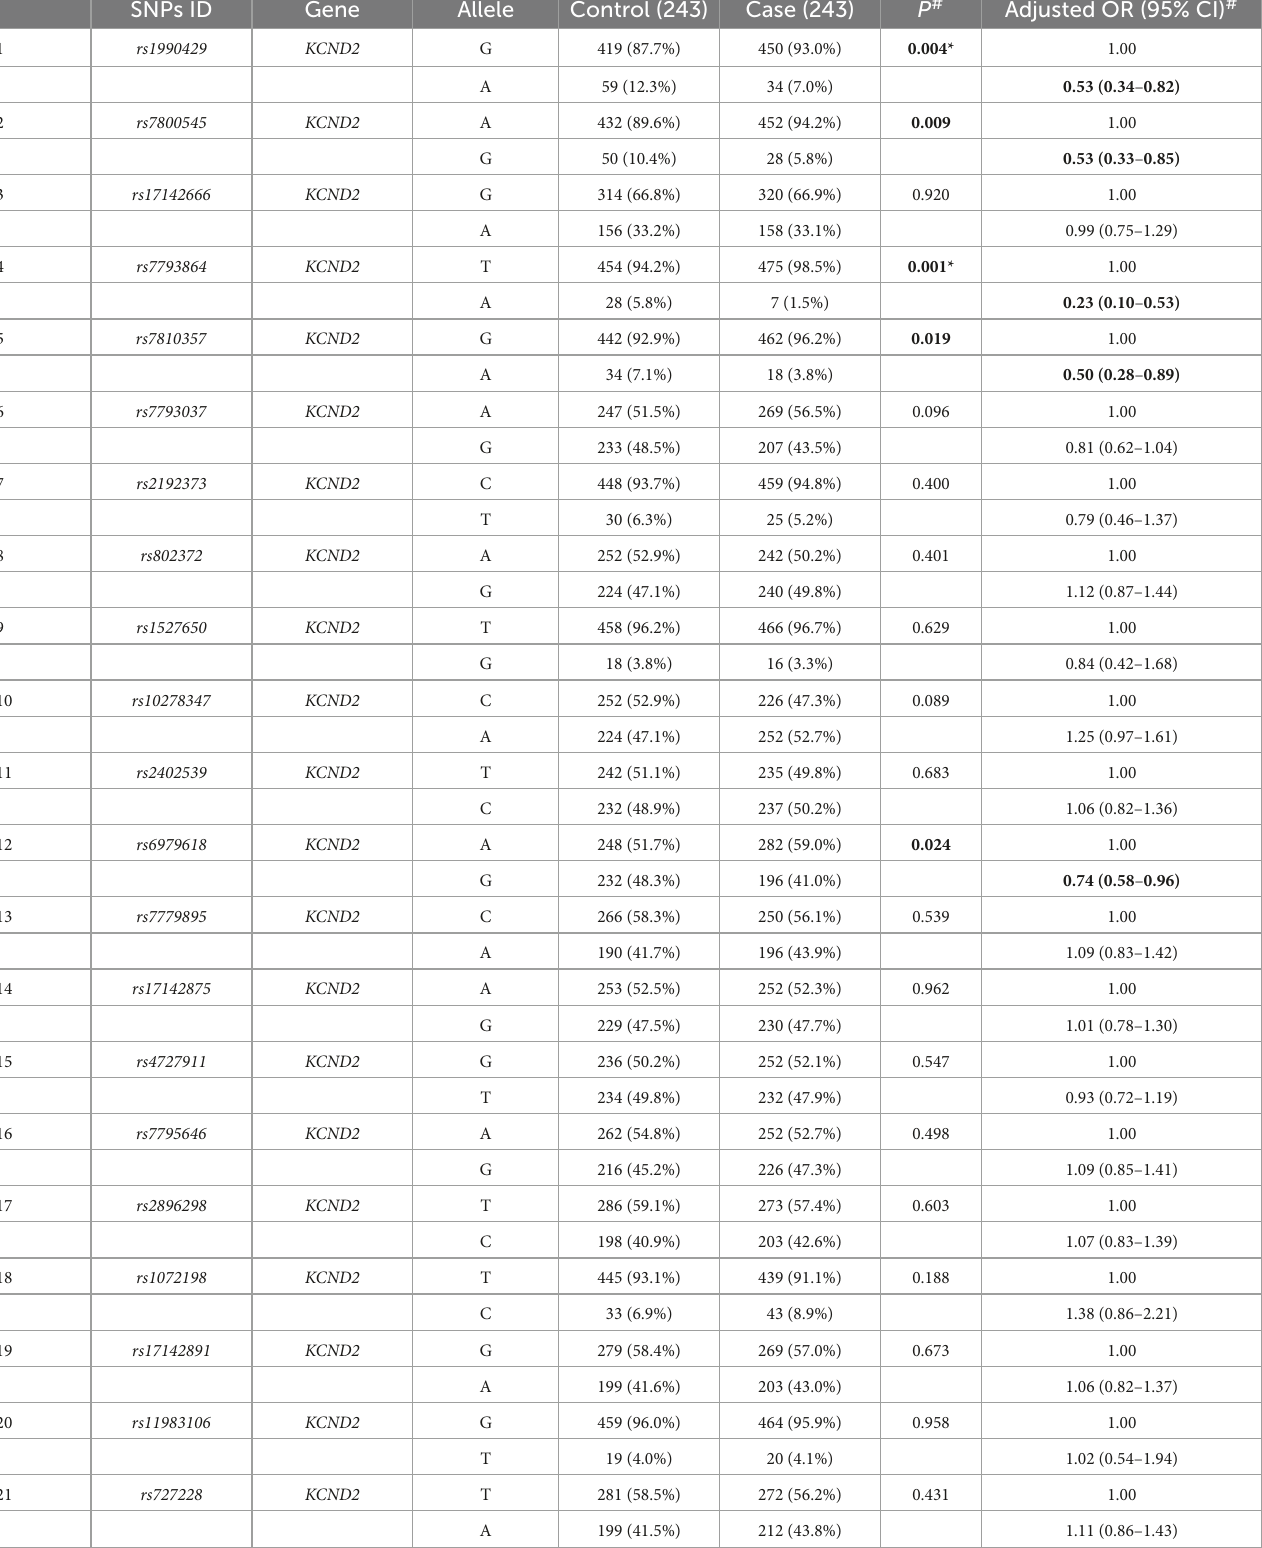
TABLE 4 Distribution of allele frequencies of KCND2 single nucleotide polymorphisms (SNPs) in cases and controls (n,